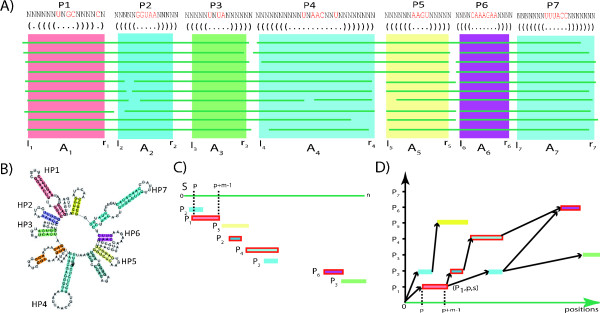
Construction of RNA secondary structure descriptors. (A) Non-overlapping alignment blocks of stem-loop regions excised from a multiple sequence-structure alignment and derived sequence-structure patterns. Since li ≤ ri <lj ≤ rj and sequence regions S[li ... ri] fold into stem-loop structures for 1 ≤ i ≤ j ≤ 7, A = A1, A2, A3, A4, A5, A6, A7 is an ordered sequence of non-overlapping alignment blocks suitable to construct an RNA secondary structure descriptor . The sequence-structure patterns , i ∈ [1, 7] of  given on top of their underlying alignment blocks describe the seven marked stem-loops shown in the RNA secondary structure (B) of the Citrus tristeza virus replication signal (Rfam: RF00193). (C) Matches of RSSPs , i ∈ [1, 7], on sequence S, sorted in ascending order of their start position. (D) Graph-based representation of the matches of , i ∈ [1, 7]. An optimal chain of collinear non-overlapping matches is determined by computing an optimal path in the directed acyclic graph. Observe that not all edges in the graph are shown in this example and that the optimal chain (indicated here by their red marked members) is not necessarily the longest possible chain.